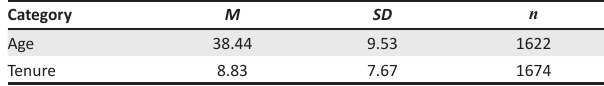
TABLE 2: Age and tenure statistics of the sample ( n = 1749).